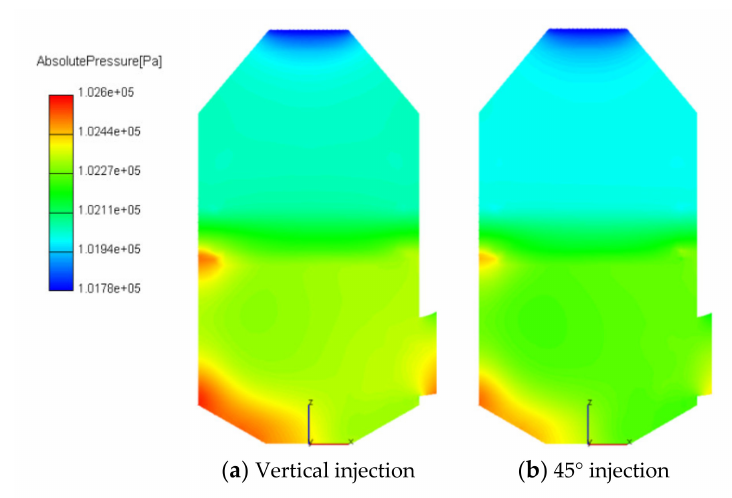
Figure 21. Pressure map inside the